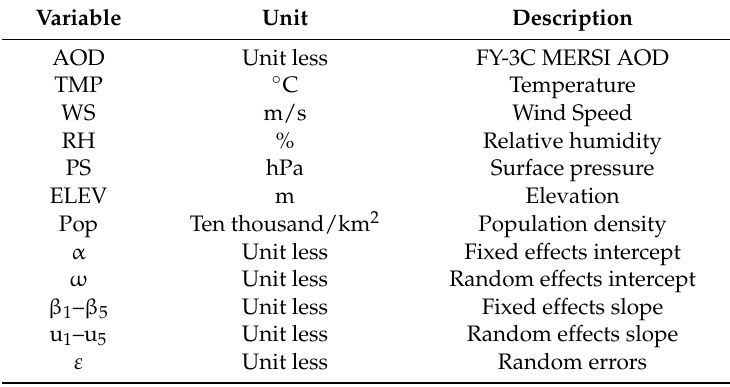
Table 1. Definitions of independent variables used in Equations